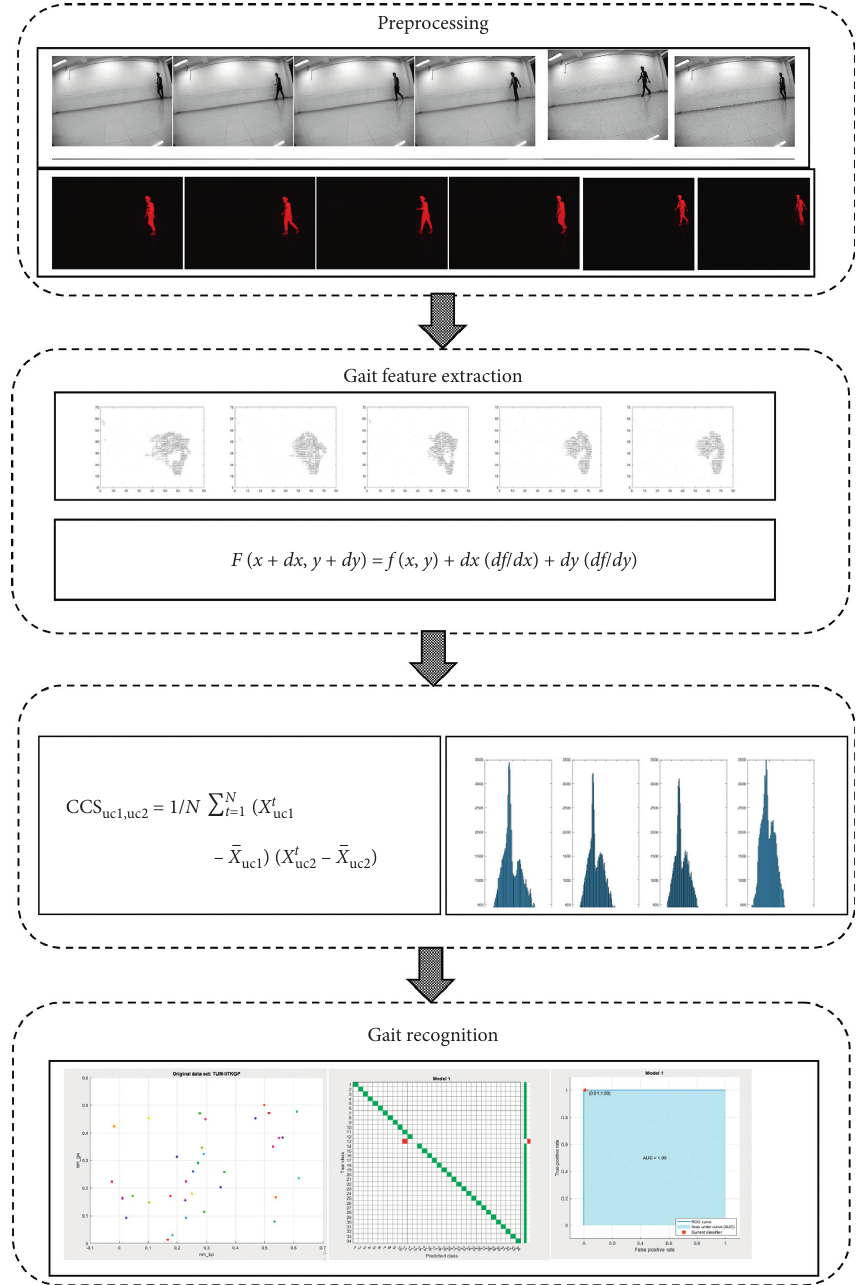
Figure 6: The workflow of DGF- and SVM-based gait verification and